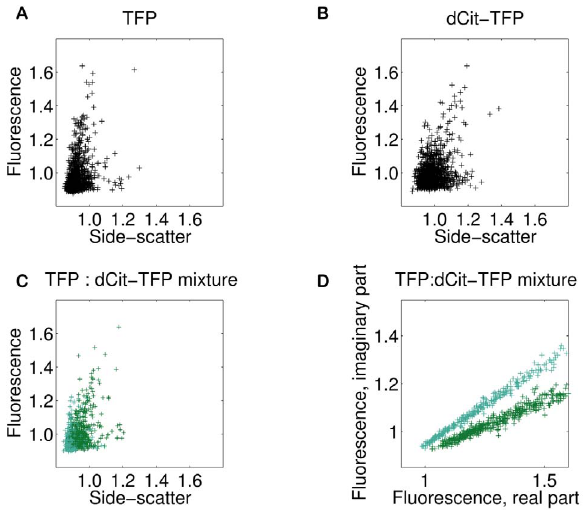
Figure 3. Detecting lifetime differences in flow. A) Intensity scatter plot for the BSY034 TFP strain. B) Intensity scatter plot for the BSY035, the dCit-TFP strain. C) Intensity scatter plot for mixture of BSY034 and BSY035, colored according to phase. Green dots represent phase delays of less than 30 degrees, blue dots, phase delays more than 30 degrees. D) Pseudophasor plot of the data from 3C. Supplemental Figure S4 shows the same plot but with a red/green color scheme. doi:10.1371/journal.pone.0109940.g003 PLOS ONE |